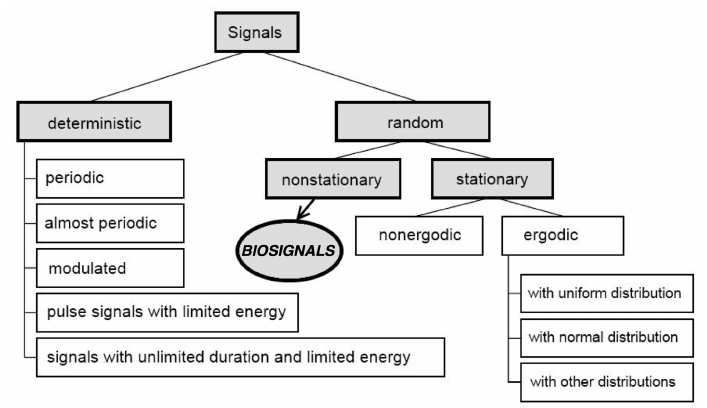
Figure 6. Basic scheme for classification of signals